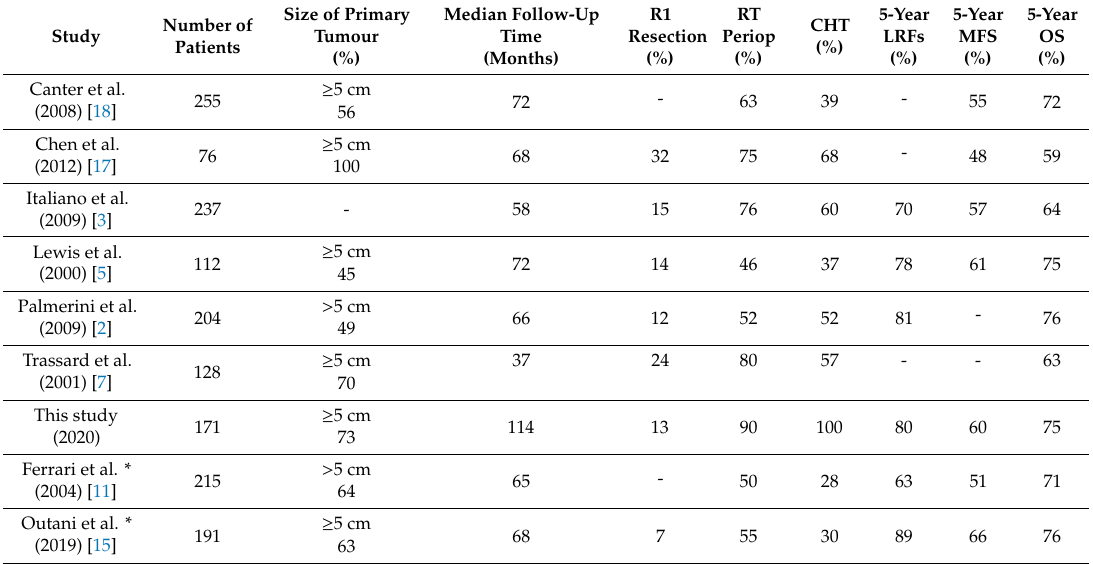
Table 4. Comparison of treatment results with the largest analyses concerning treatment of patients with localised synovial